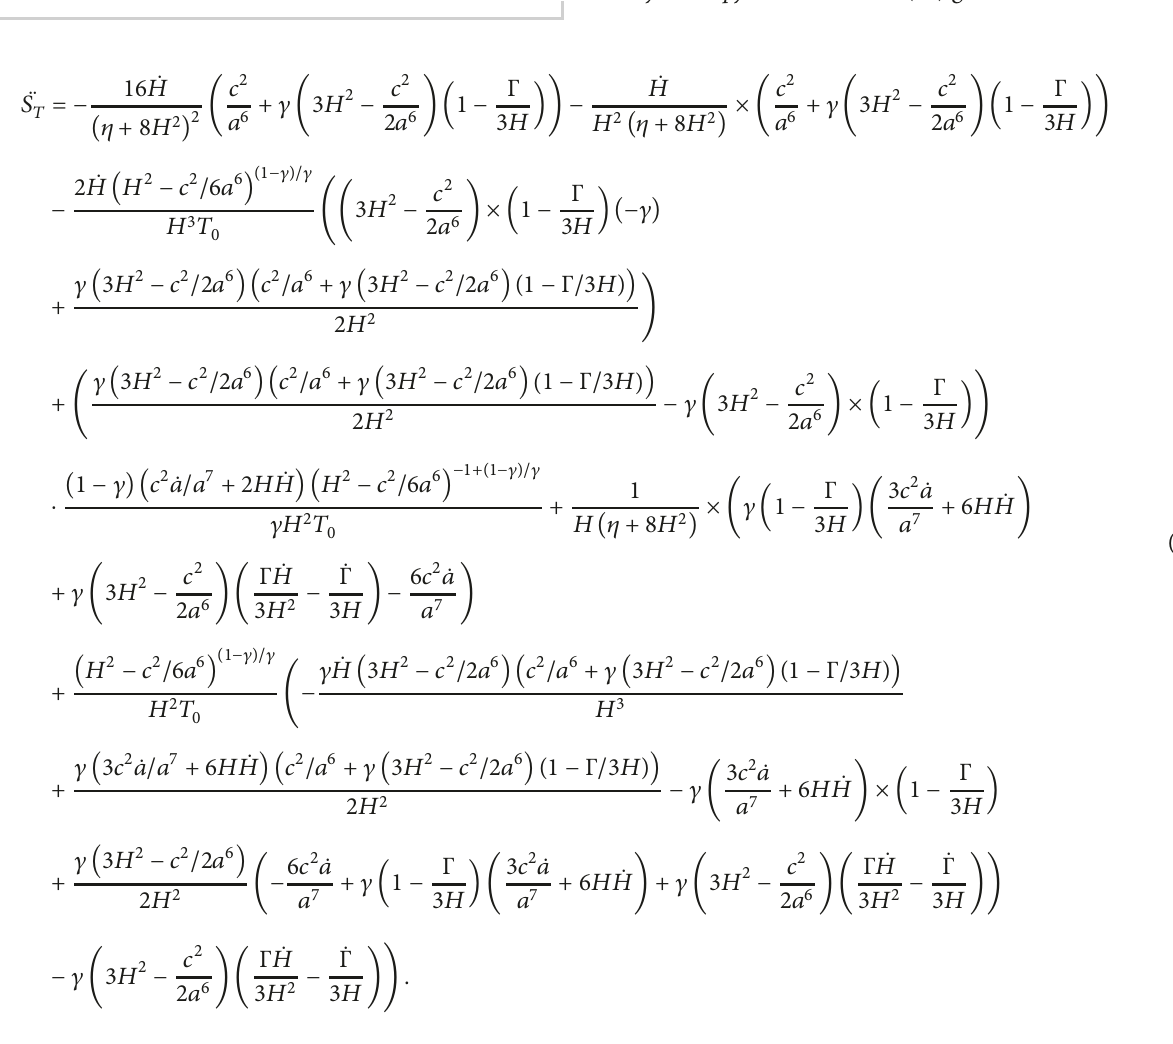
̈𝑆 𝛾 for power law correction when Γ = Γ(𝑡) . Figure 11: Plot of 𝑇 versus ̈𝑆 𝛾 for three values of 𝑇 by keeping the The plot of easily the validity of thermodynamical equilibrium for all 𝑇 versus ̈𝑆 < 0 . values of 𝑇 with same values is above mentioned (Figure 11); one can observe 𝑇 Renyi Entropy. For variable Γ , (38)